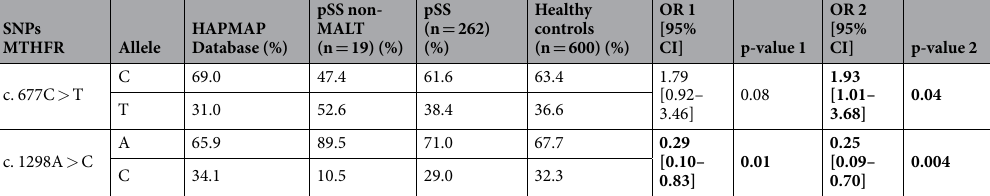
Table 3. Prevalence of MTHFR c. 677C > T T and MTHFR c. 1298A > C C allele in the pSS non-MALT patients, pSS patients and healthy control group. Allele analysis was performed with Shesis software (statistically significant if p < 0.05). OR 1, p-value 1: pSS non-MALT vs pSS, OR 2, p-value 2: pSS non-MALT vs Healthy Controls. MTHFR: methylene tetrahydrofolate reductase, pSS: primary Sjogren’s syndrome. MALT: mucosa- associated lymphoid tissue, SNP: single nucleotide polymorphisms, OR: odds ratio, HAPMAP: haplotype map, vs: